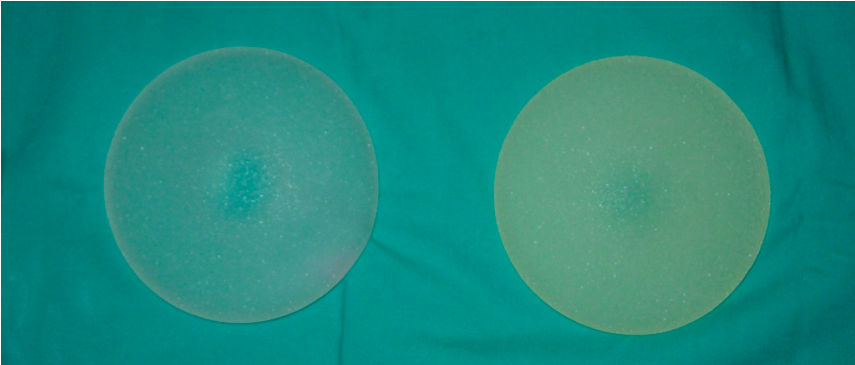
Figure 1. Digital images of breast prostheses, for example. On the left, a never-implanted sample having a white translucent colour; on the right, a six-month explanted sample with a dark yellow colour.